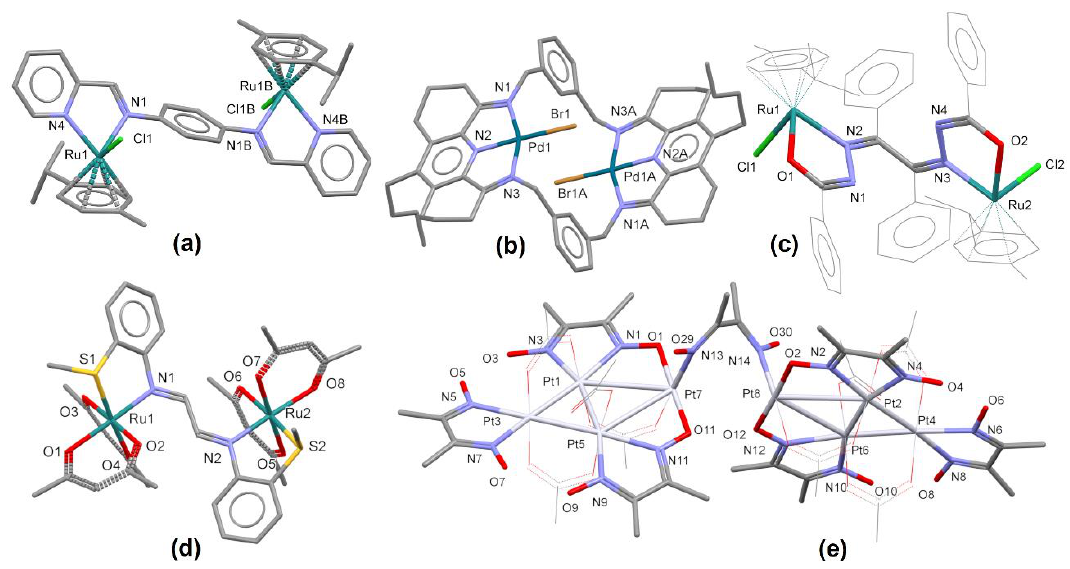
Figure 9. ( a ) Diruthenium complex with chelating κ 2 -N,N’ pockets [153] (CSD Refcode AZWQOL); ( b ) cyclic binuclear complex with robust pincer type 6e κ 3 -N,N’N” coordination mode [154] (CSD Refcode MOTZUT); ( c ) binuclear complex of ruthenium(II) arene benzil bis(benzoylhydrazone) with coordination chelating κ 2 -N,O pockets [155] (CSD Refcode QESSUF); ( d ) binuclear Ru complex with non-innocent diimine ligand binding through coordination chelating κ 2 -N,S pockets [123] (CSD Refcode KEHSOH); ( e ) octaplatinum complex with Pt 3 metallic clusters stabilized by bridging and chelating dimethylglyoxime ligand molecules [156] (CSD Refcode MEMLUL). Hydrogen atoms, solvent and counterion molecules were omitted for clarity.